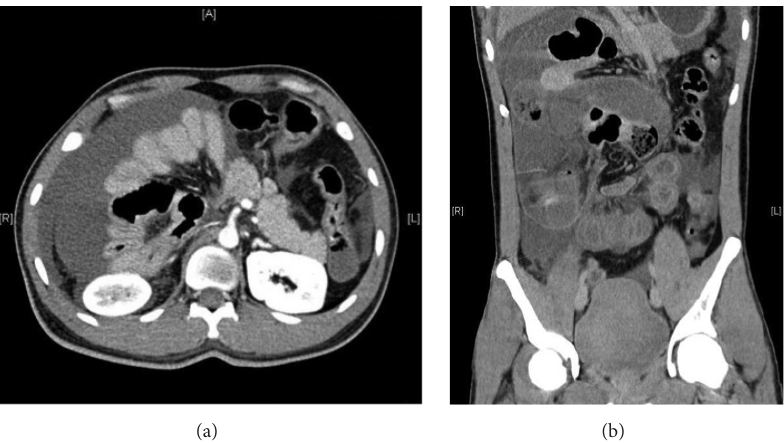
Figure 3: Contrast-enhanced CT in (a) axial and (b) coronal sections showing clustering of dilated small bowel loops in the right side of the abdomen, with no visualization of an encapsulating sac. The superior mesenteric artery is to the right of the superior mesenteric vein (a).